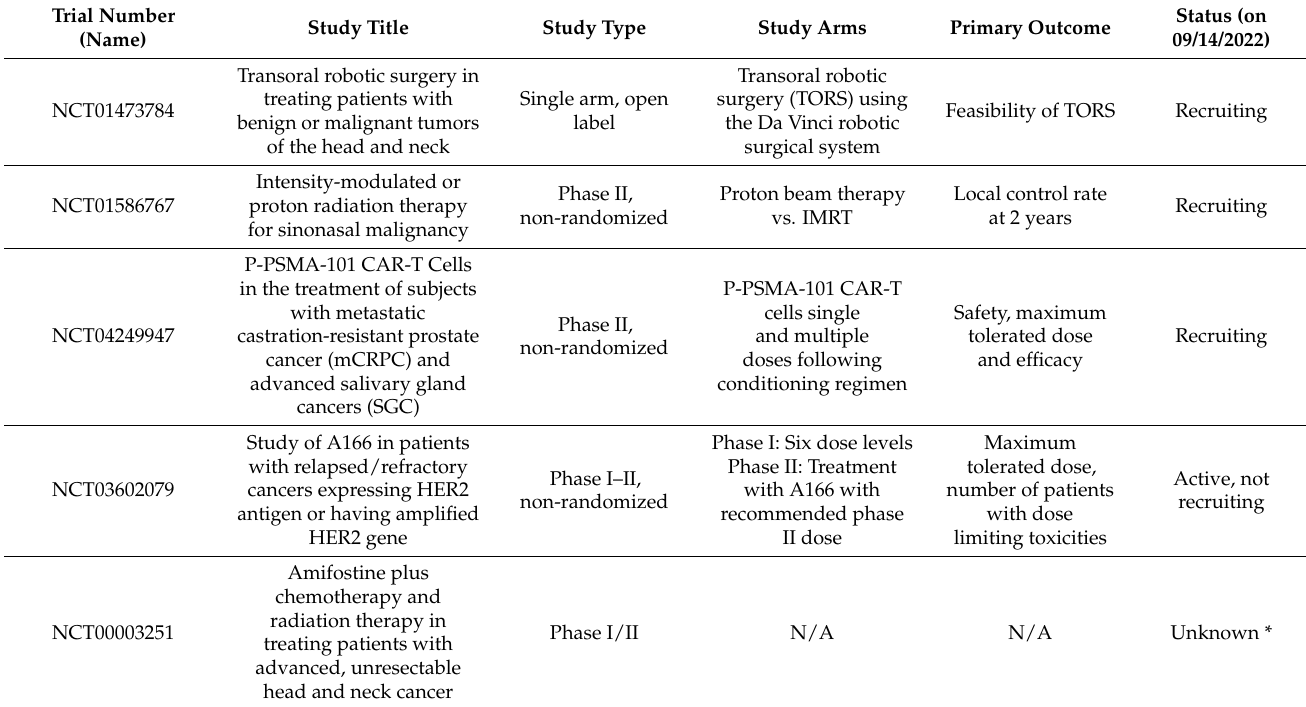
Table 5. Selected ongoing clinical trials enrolling patients with mucoepidermoid carcinoma (Source: https://clinicaltrials.gov/, accessed on 14 September